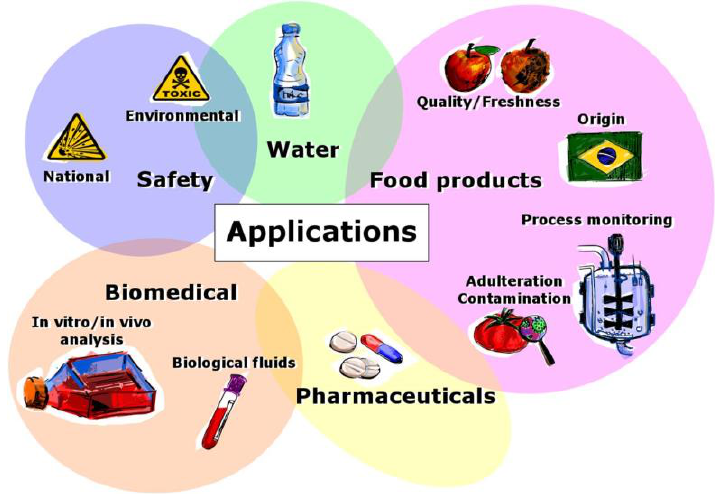
Figure 4. Wide range of applications of electronic tongue systems.